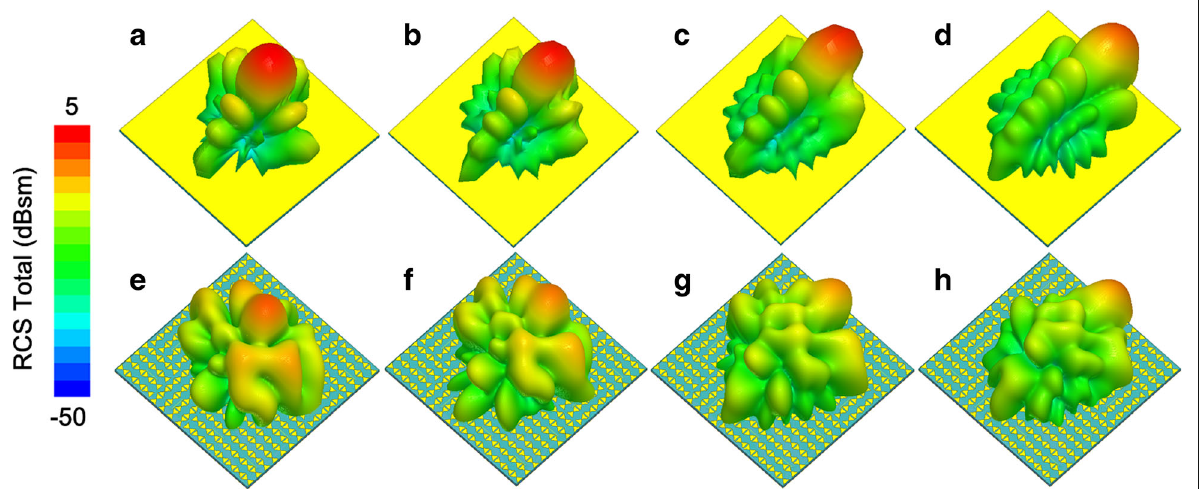
Fig. 10 Diffusion scattering properties of the EMMS under oblique incidence at 6 GHz. a – d Scattering patterns of metal board with an incident angle of 15° ( a ), 30° ( b ), 45° ( c ), and 60° ( d ). e – h Scattering patterns of EMMS with an incident angle of 15° ( e ), 30° ( f ), 45° ( g ), and 60° ( h